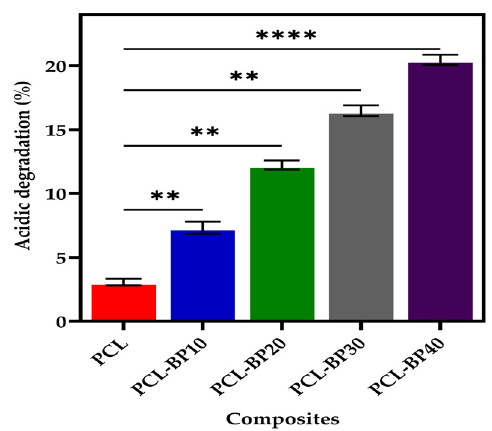
Figure 6. Acidic degradation of PCL and PCL-BP composites after 28 days of immersion in acidic medium ( n = 3, ** p ≤ 0.01, **** p ≤ 0.0001).